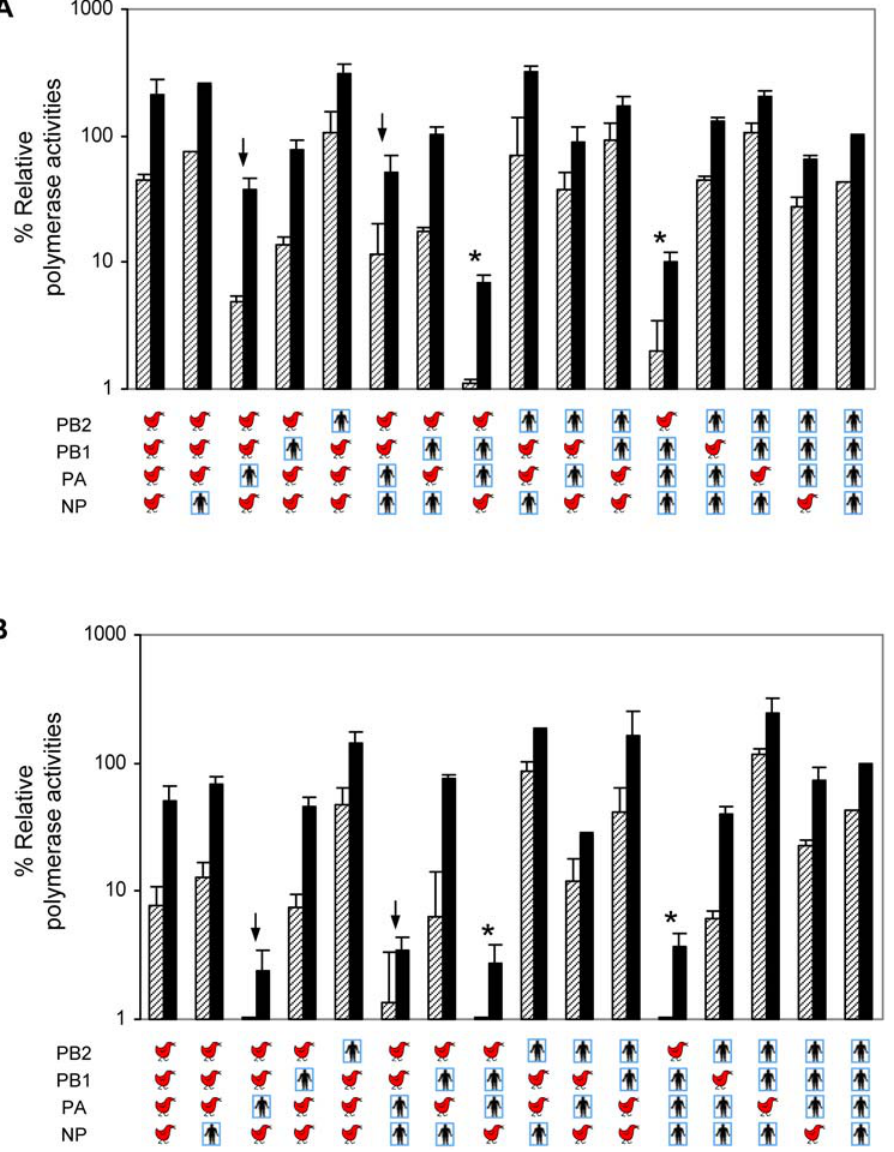
Figure 5. Polymerase activity of avian-human viral ribonucleoprotein (RNP) complexes. (A) A549 cells were transfected in duplicate with pPol1-NS-Renilla and pSV40-Luc reporter plasmids, together with plasmids expressing PB2, PB1, PA and NP from either WY03 (human symbol) or TH04 (chicken symbol) viruses. Cells were incubated at 33 u C (hatched bars) or 37 u C (solid bars) for 24 hours and cell lysates were analyzed to measure Renilla and firefly luciferase activities. The latter was used to normalize transfection efficiency. Values shown represent the activities of each RNP relative to that of WY03 measured at 37 u C (100%). (B) Viral RNP activities derived from WY03 (human symbol) or VN04 (chicken symbol) viruses are shown as described in panel